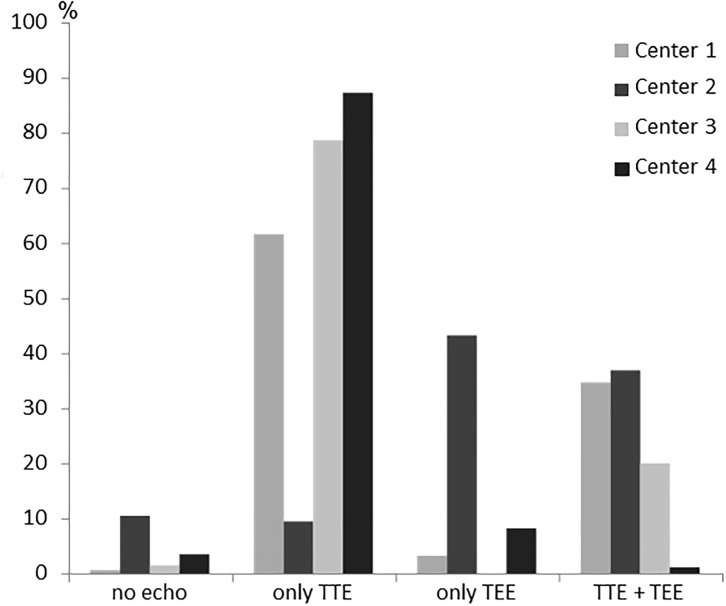
Rates of echocardiographies in each study centre.